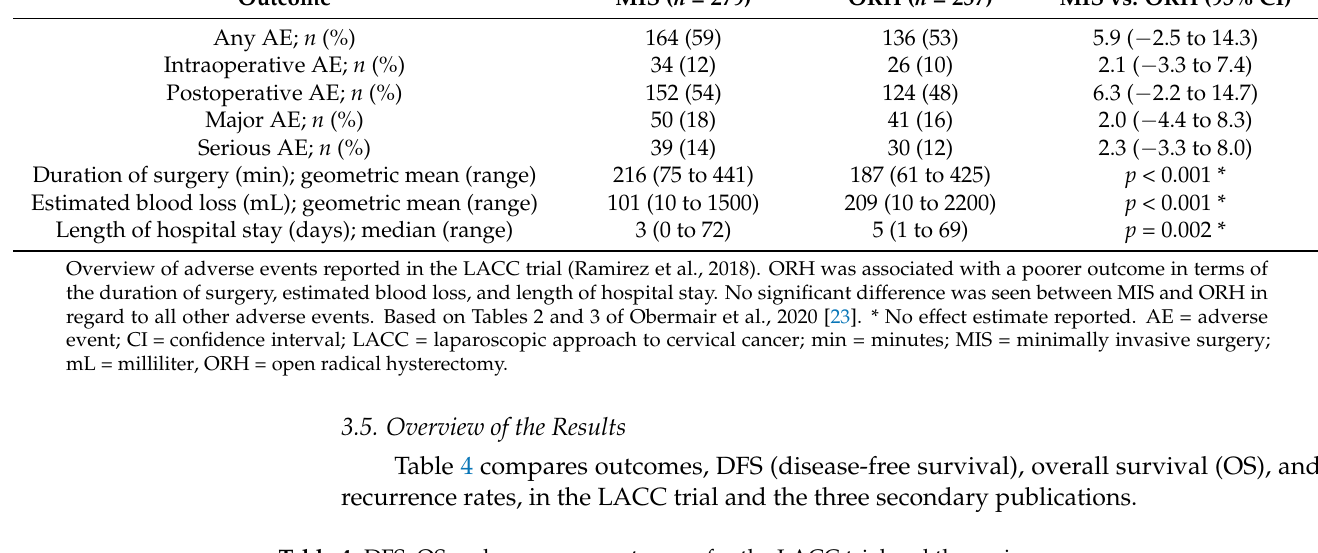
Table 4. DFS, OS and recurrence outcomes for the LACC trial and the